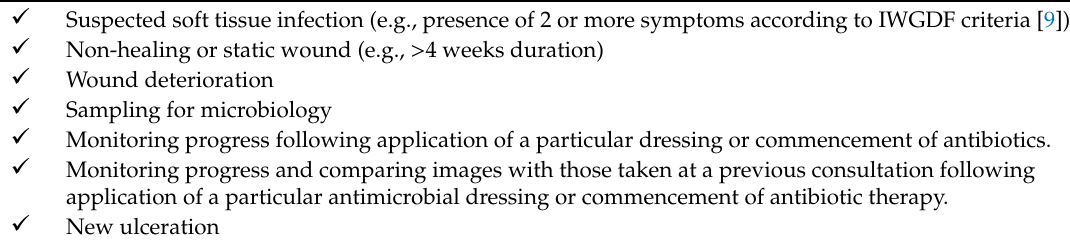
Table 1. Criteria for using bacterial fluorescence imaging.